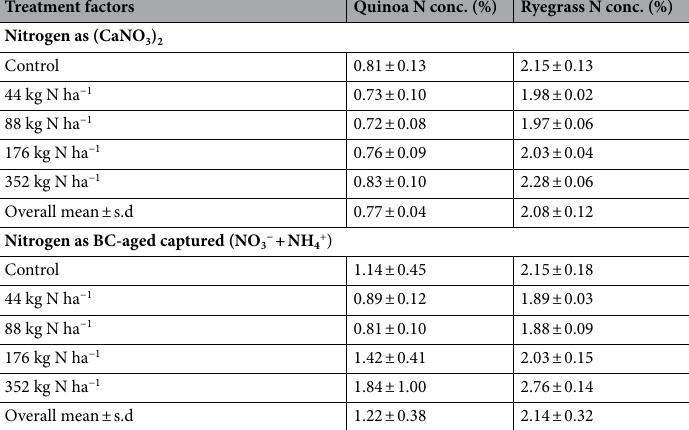
Treatment factors Quinoa N conc. (%) Ryegrass N conc.